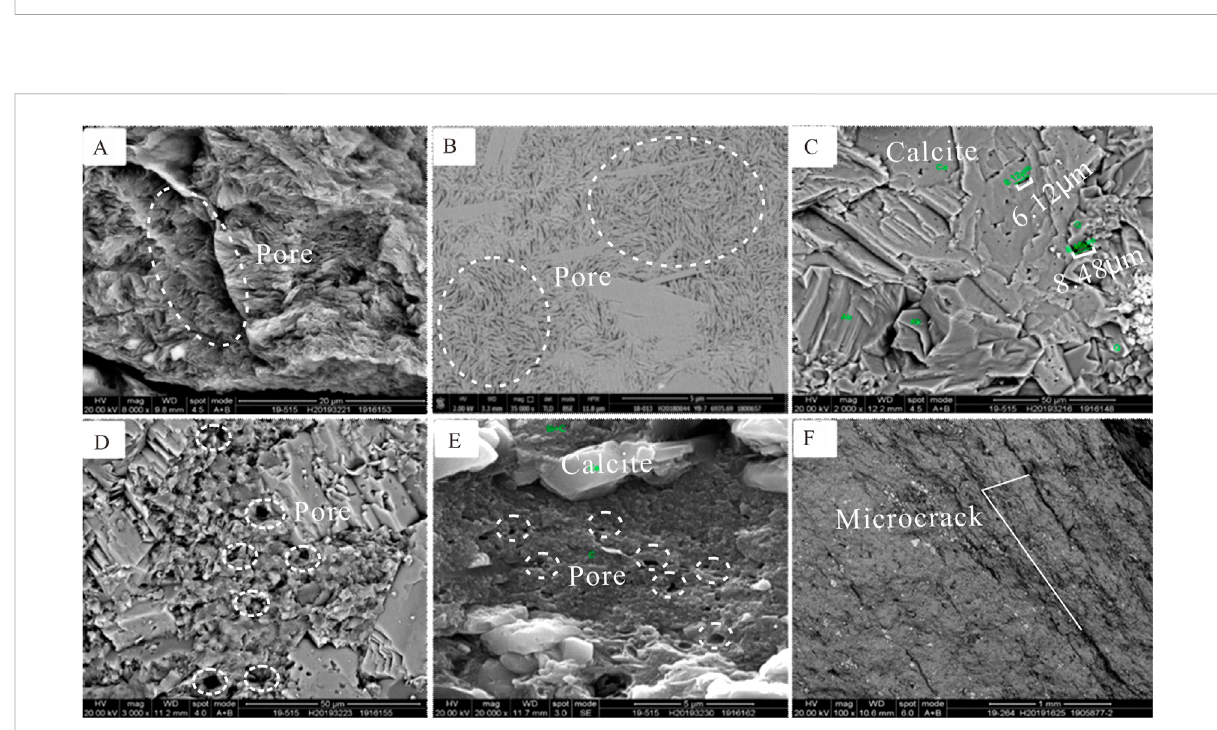
FIGURE 4 Typical reservoir space of tuffaceous section. (A) tuff, shrinkage pores developed between mica and clay sheets, 6,811.9 m, Well SY1-1; (B) Tuffaceous mudstone, shrinkage pores of clay mineral, 6,935.69 m, Well Y7; (C) sedimentary tuff, with enlarged calcite dissolved pores (below 6 microns), quartz and albite cemented in intercrystalline pores, 4,945.65 m, Well M1; (D) sedimentary tuff, intercrystalline pores developed for siderite, 6,867.21 m, Well SY1-1; (E) sedimentary tuff, organic pores developed, 6,867.21 m, Well SY1-1; (F) Tuffaceous mudstone, crack developed, 6,936.07 m, Well